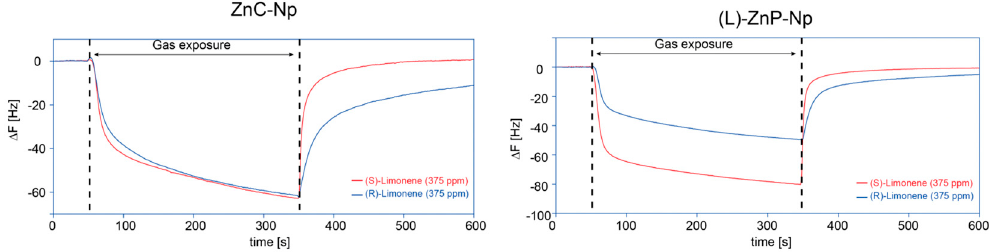
Figure 1. Time evolution of the sensor signal (change of QMB frequency) of chiral porphyrin on gold ( left ) and ZnO nanoparticles ( right ) exposed to the two enantiomers of limonene.